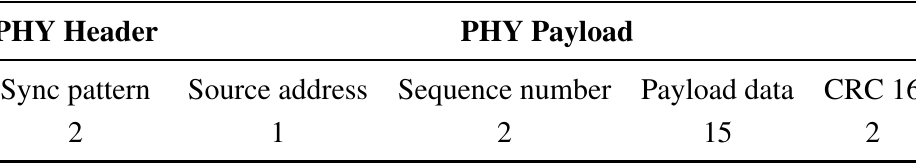
Table 2. Frame format and field lengths (bytes) used in the experimental protocol.